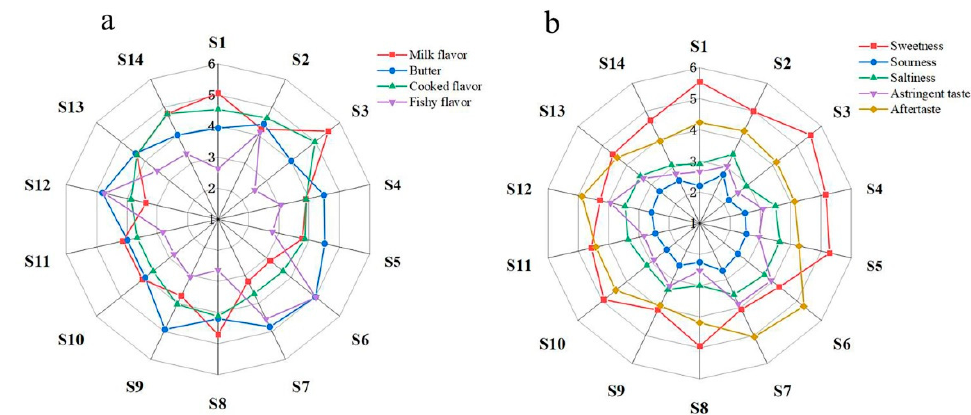
Figure 2. Radar chart of the sensory evaluation of fourteen milk powder samples available in the Chinese market. Samples were individually assigned a label within the range of S1–S14. ( a ) Represent odor score, ( b ) represents taste score.